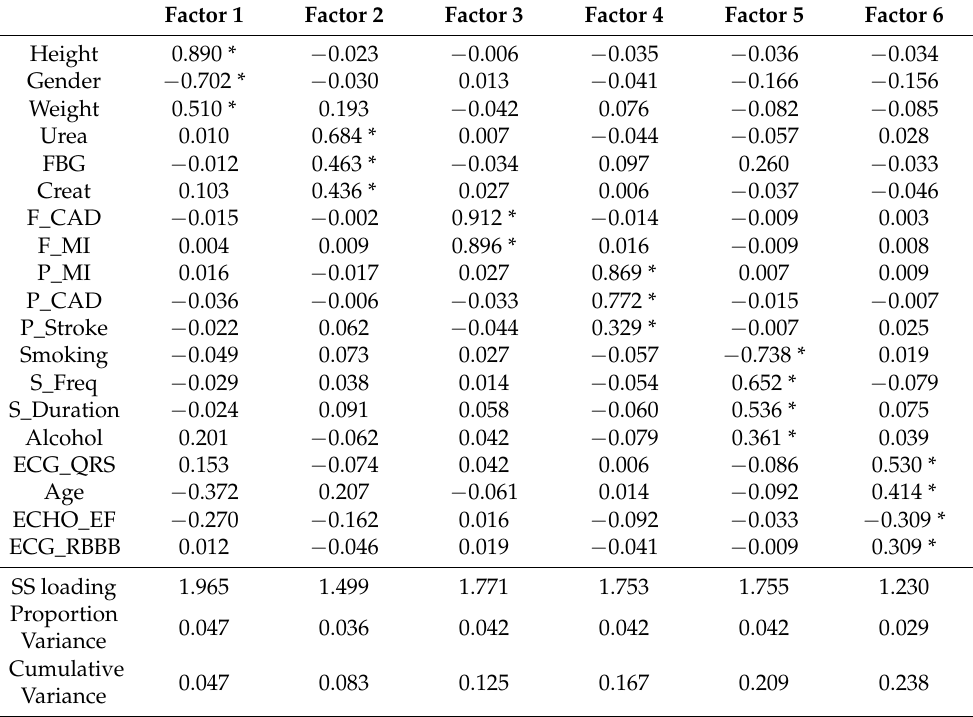
Table 8. Values of factors loadings with the rate of variance for each